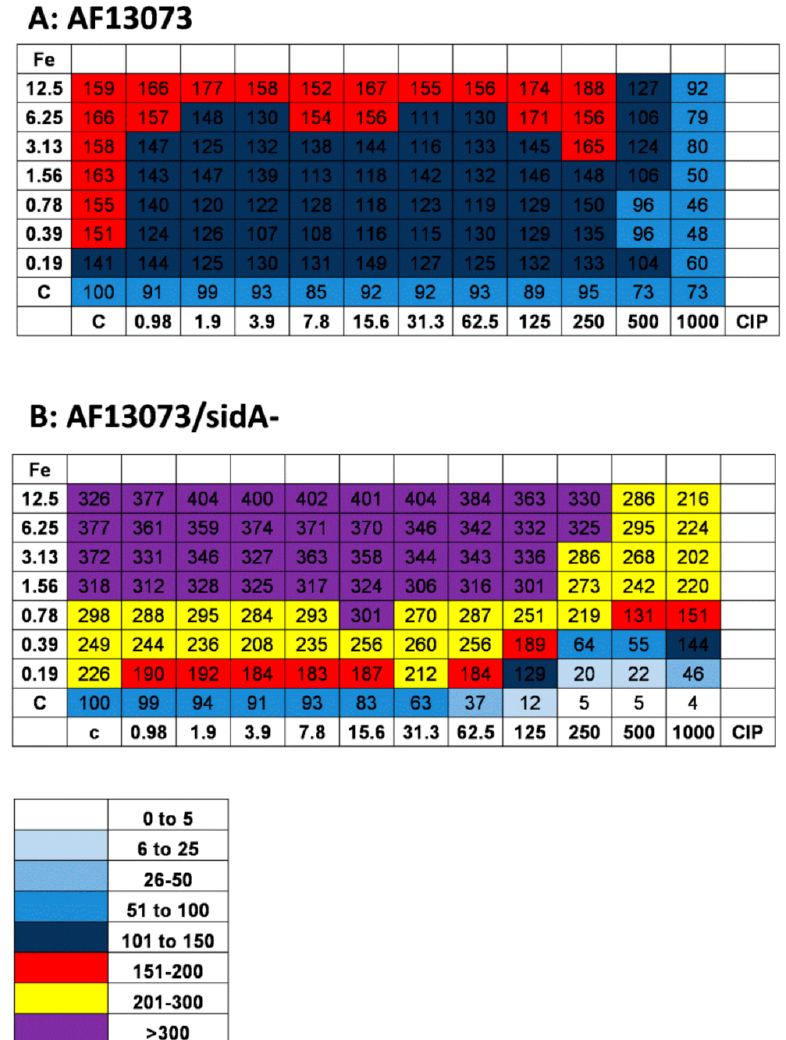
Figure 5. Iron and CIP interact and affect A. fumigatus biofilm metabolism. CIP (final concentra- tion 0.98–1000 µ g/mL in RPMI 1640 medium) was combined with FeCl 3 (iron; final concentra- tion 0.19–12.5 µ M in RPMI 1640 medium) using ( A ) AF13073 conidia (10 5 conidia/mL in RPMI 1640 medium) or ( B ) AF13073/ sidA - conidia (2 × 10 5 conidia/mL in RPMI 1640 medium). As the siderophore-deficient mutant has slower growth, using double the amount of conidia assured similar growth to the wildtype in the untreated controls for both fungi. The assay plates were incubated at 37 ◦ C overnight. Fungal metabolism was measured by an XTT assay. Metabolism in the presence of RPMI alone was regarded as 100%, and compared to each supernatant dilution. The color chart visualizes groups of iron/CIP combinations with similar growth. A: n = 2; B: n =